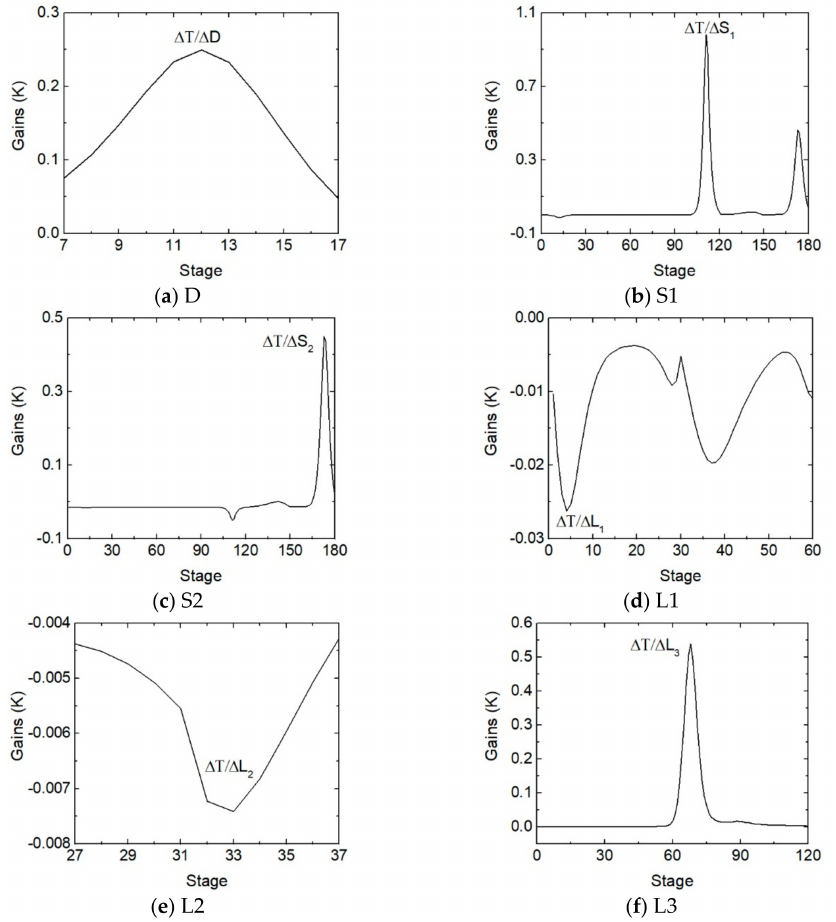
Figure 4. Sensitivity analysis profiles: ( a ) D; ( b ) S1; ( c ) S2; ( d ) L1; ( e ) L2; ( f )